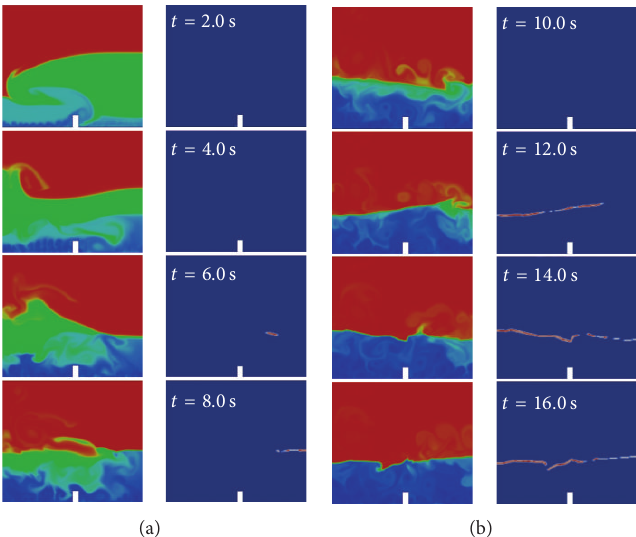
Figure 4: Time sequence of the volume fraction field (left of each column) and the 𝐶 𝛼 field (right of each column) showing the region of active interface sharpening showing the evolution of the separation process and appearance of a sharp interface.